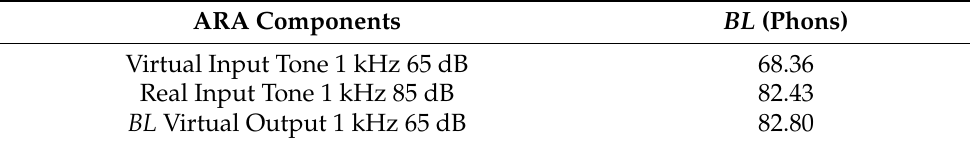
Figure 13. Spectrum analysis of BL mix input-output. (a) Tone 1000 Hz 65 dB (virtual source). (b) Tone 1000 Hz 85 dB (real environment). (c) BL tone 1000 Hz 65 dB ( BL mix result). Table 2. BL inputs and output of 1 kHz tones.